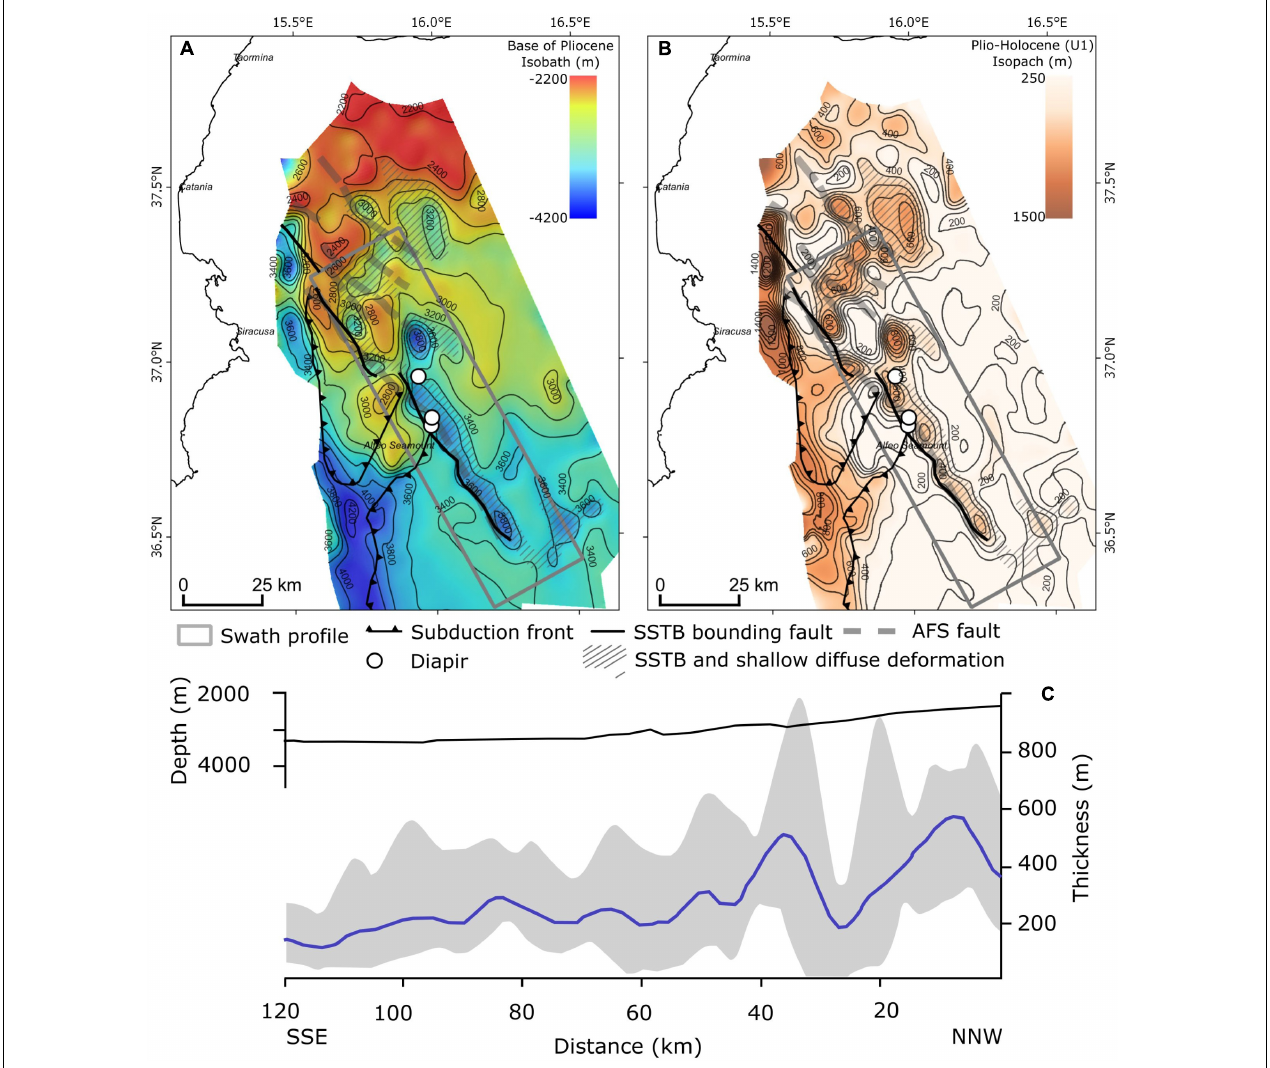
FIGURE 8 | (A) Map of the base of Pliocene. (B) Map of the thickness of the Pliocene-Holocene unit obtained by subtracting a bathymetric surface (smoothed to avoid the influence of small-scale topographic features of the seafloor) from the base of the Pliocene. (C) Swath profile (outlined by the gray rectangle in panels A,B ) showing the average thickness (blue line) of the Pliocene-Holocene unit, along with the envelope of minimum and maximum values (gray shading), and the average depth of the seafloor. Seafloor fault traces in (A,B) are redrawn from Gutscher et al. (2016). In all panels, the star marks the location of the Shallow Syn-Tectonic Basin (SSTB) shown in the seismic sections in Figures 4 , 5